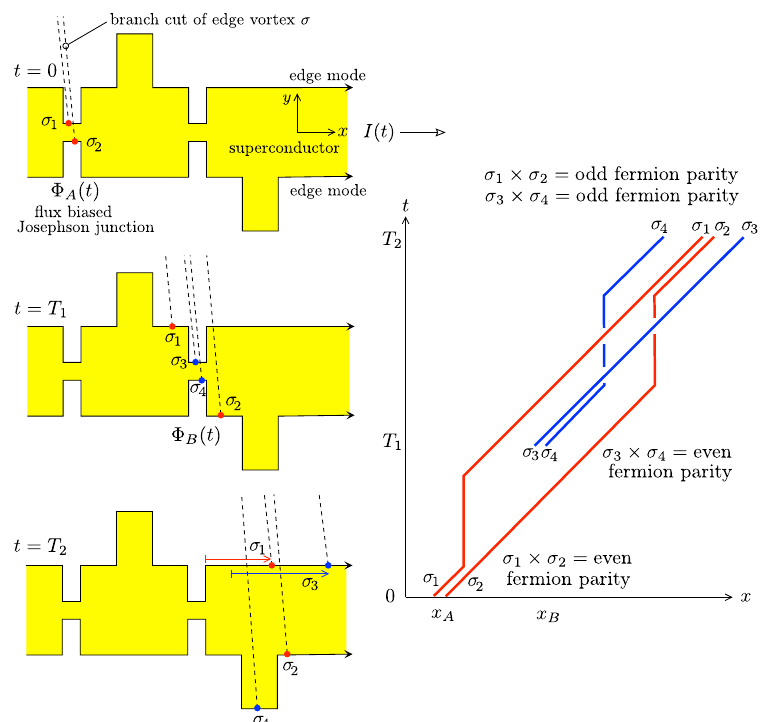
Figure 5: Braiding of vortices moving in the same direction. The three diagrams at the left show the edge vortices at three instants in time; the vortices are produced by an h / 2 e flux increment, first at Josephson junction A (time t = 0) and then at Josephson junction B (time t = T ). Each vortex induces a 2 π phase shift of the 1 order parameter across a branch cut, indicated by the dashed lines. The Majorana operator γ associated with vortex σ changes sign when the vortex crosses a branch n n cut from some other vortex. This happens once for vortex 1 and twice for vortex 3, so γ changes sign but γ does not. The vortices 2 and 4 do not cross a branch 1 3 cut, so γ and γ are unaffected. In the space-time braiding diagram the crossing 2 4 of a branch cut is indicated by an overpass. At the end of this process both fermion γ γ parity operators i γ and i γ change sign. Hence two fermions are produced, 1 2 3 4 one shared by vortices 1 and 2 and one shared by vortices 3 and 4. This can be detected electrically as a sign change of the current pulse I ( t ) produced by the fusion of vortices 1 and 2 when they enter a metal